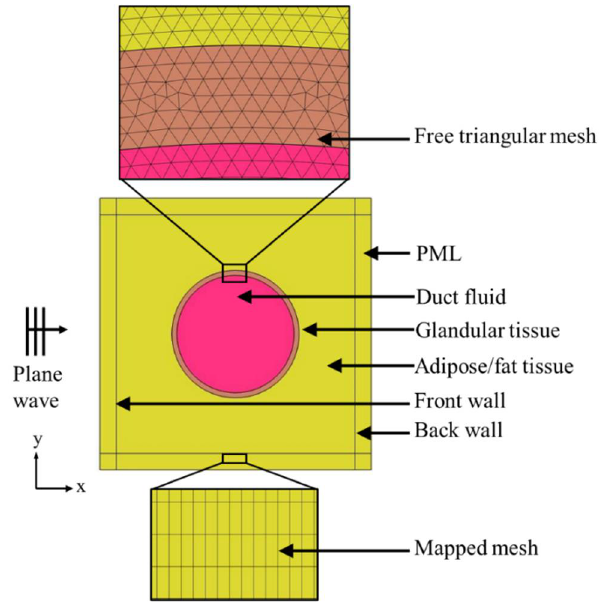
Figure 2. Computational model description.